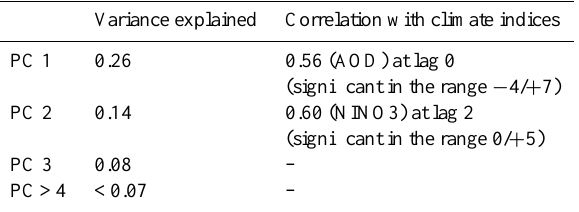
Table 3. PRE variability forced by the SM decomposed through EOF analysis. Each line displays the EOF explained variance (col- umn 2) and the corresponding PC correlation with relevant climatic indices (column 3). AOD is the stratospheric aerosol optical depth. NINO3 index is defined as the average of the sea surface temper- ature in the tropical Pacific region (5 ◦ S–5 ◦ N, 210–270 ◦ E). Here the maximum PC correlation is reported considering lagged corre- lations in the range − 16 to + 16. Only the correlation coefficients significant at the 1% level are reported.